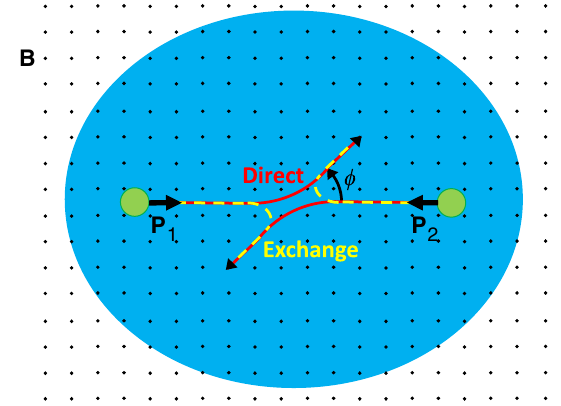
FIG. 2. Scattering of two anyonic molecules. Similarly to Fig. 1, two indistinguishable anyonic molecules (green circles) formed by the binding of the same number of quasiholes to a pair of identical impurities in the bulk of a FQH fluid (blue region) are considered. The two molecules are given momentum kicks against each other ( P 1 and P 2 , respectively). Because of their indistinguishability, two scattering channels contribute to the differential scattering cross section at an angle ϕ [see Eq. (62)]: The two channels are labeled as “ direct ” (red, solid trajectories) and “ exchange ” (yellow, dashed ones) and involve a relative phase determined by the anyonic statistics. As one can guess from textbook two-slit interference, information about the statistics can be extracted from the global position of the interference fringe pattern, which is illustrated in the next